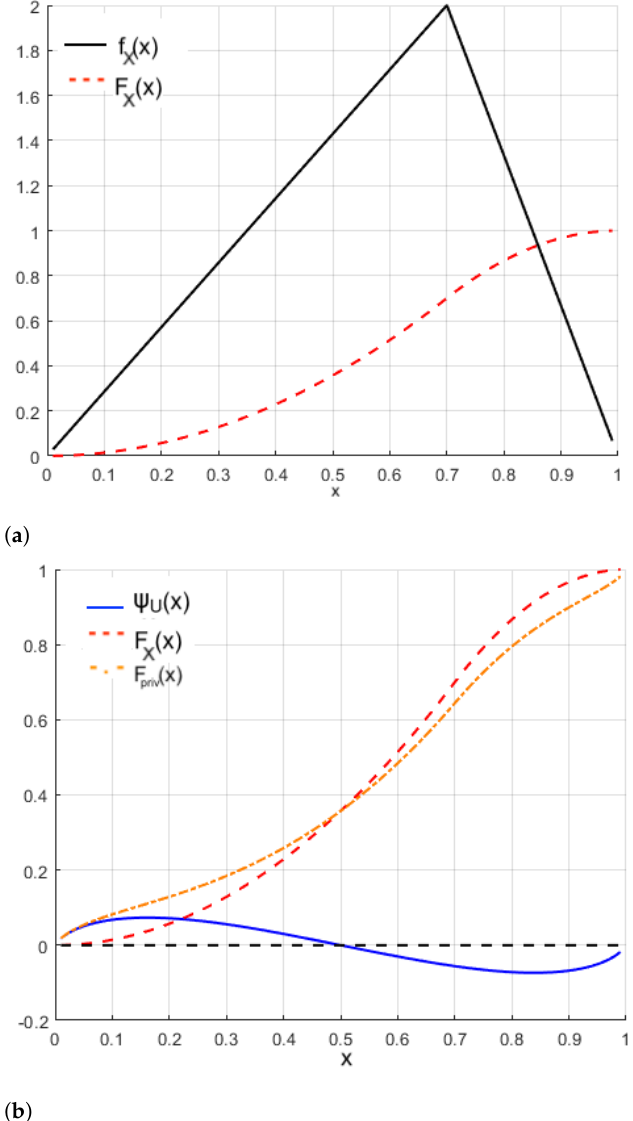
Figure 7. Plots of: ( a ) PDF and CDF of the triangular distribution; and ( b ) wavelet perturbation (— blue), triangular (- - red), and perturbed triangular (- · - orange)